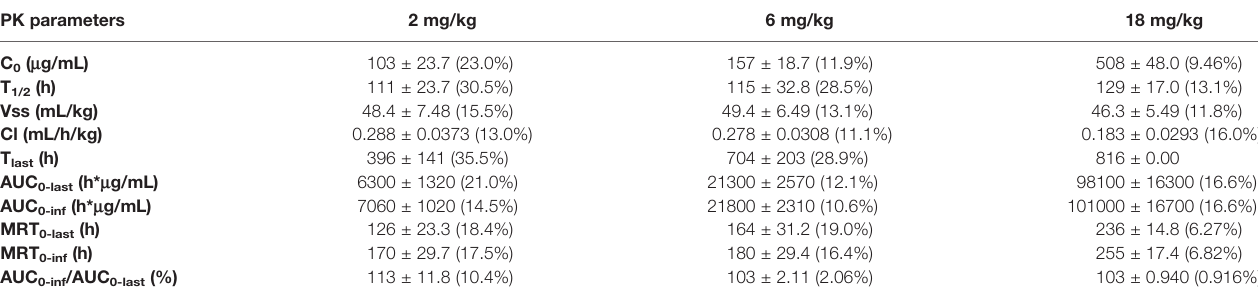
TABLE 4 | PK parameters of GLS-010 after single vd administrations of 2, 6, and 18 mg/kg in cynomolgus macaques. PK